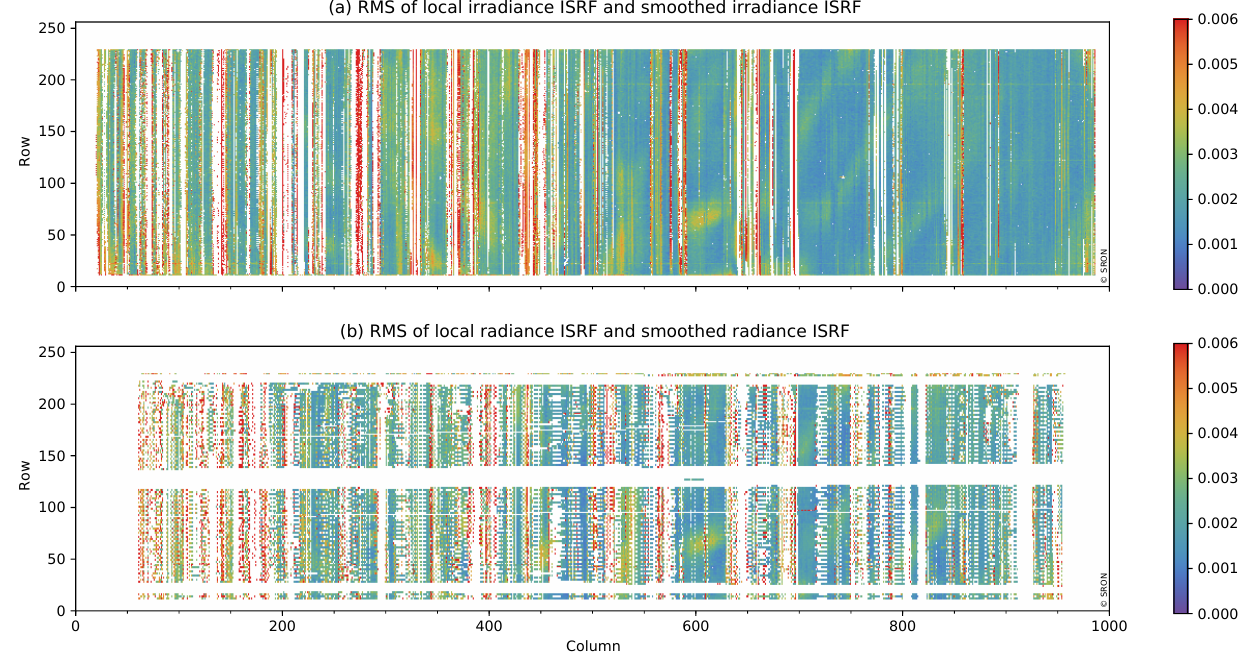
Figure 15. Fit quality of the smoothed ISRF using the (a) irradiance port and (b) radiance port. No measurements are performed in the white edges. (a) White vertical stripes are due to saturation in the measurements, and red vertical stripes are due to nearby saturation or laser instabilities. (b) White areas are due to partly illuminated